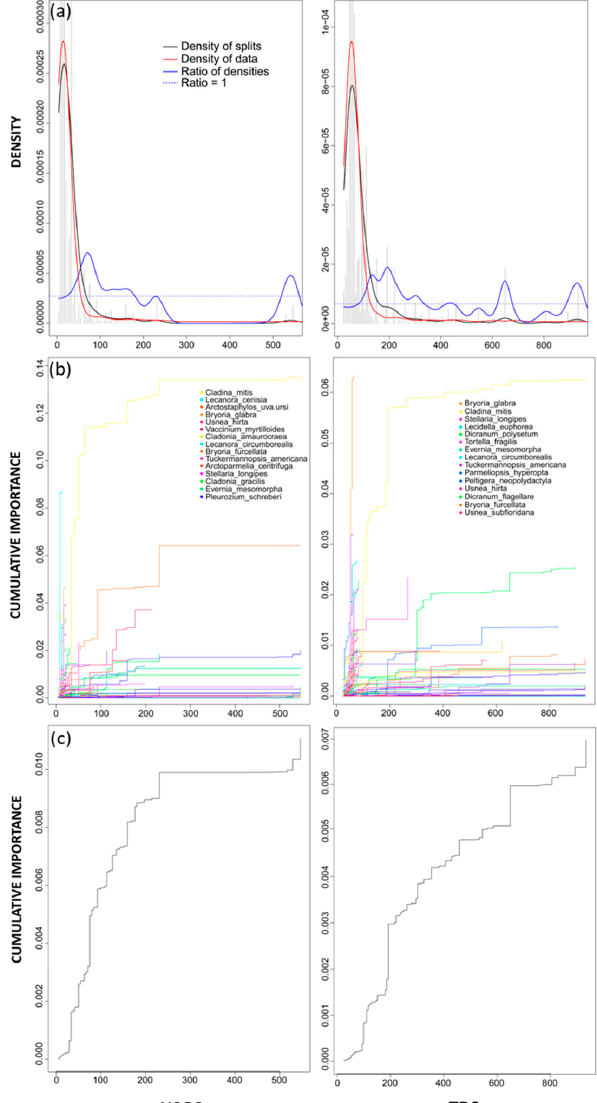
Figure 5. (left column) gradient forest results for HSO 3 and (right column) TDS. ( a ) Densities plot with binned split importance values (grey histogram bars), the density of data (red line), the density of splits (black line), the ratio of split-over-density (blue line). The dashed line is where the ratio = 1. Relatively greater community level changes (high split importance values) occur when the ratio of densities > 1; ( b ) species cumulative importance plot showing the cumulative distribution of splits importance scaled by R 2 . Each line represents an individual species, and the legend identifies the top 15 species experiencing the largest composition changes across the gradient; and ( c ) community cumulative importance plots calculated by the sum of weighted averages of all species in ( b ) and showing the overall pattern of compositional change for all